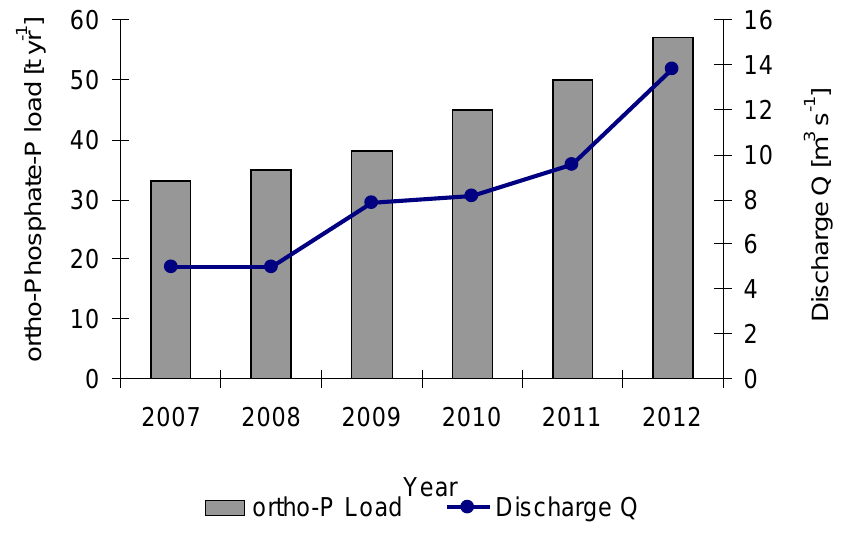
Figure 7. Concentrations of total nitrogen (TN) (mg·L −1 ) in a longitudinal profile from the Khentii Mountains (Sugnugr, Kh_Trib_2, natural reference conditions) to the KRB outlet (Kh_Main_4) between 2007 and 2012. For each water body the number of analyzed water samples is indicated ( n ). For exact locations of the water body and sampling sites, see Figure 3, Tables 1 and 5. (Monitoring data of MoMo project).